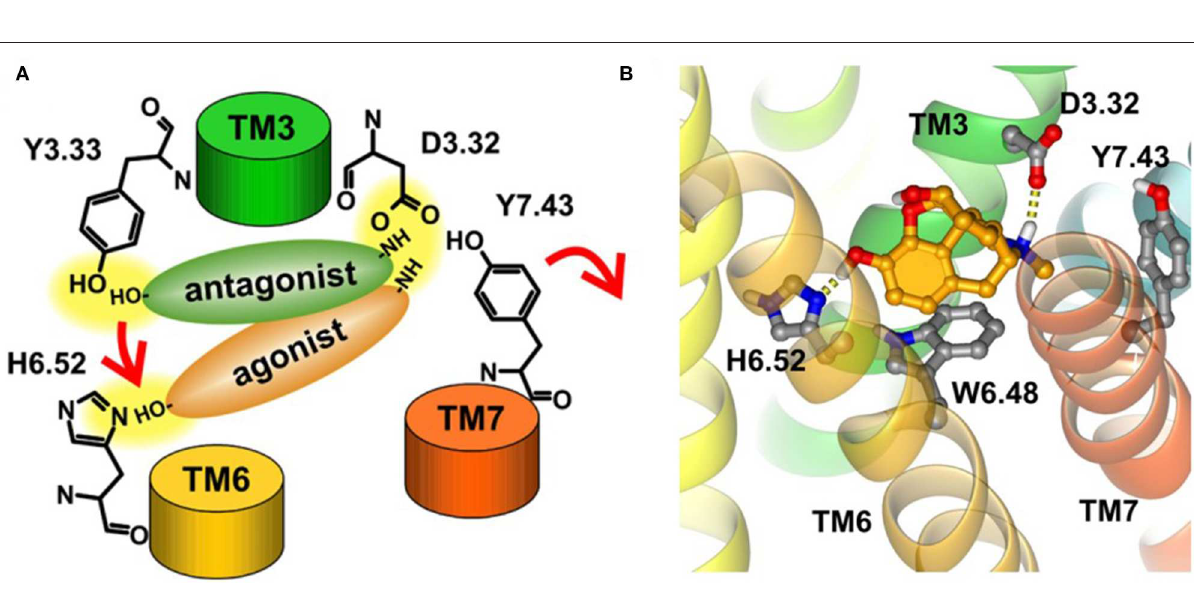
FIGURE 7 | (A) Proposed binding modes of antagonists and agonists in opioid receptors. Red arrows indicate the suggested steps of agonist action. (B) Horizontal position of W 6.48 interacting with morphine. The ligand is bound to H 6.52 and D 3.32